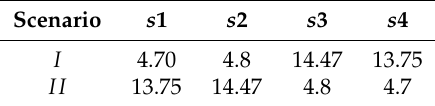
Table 1. Price scenarios (given in cents per kWh).